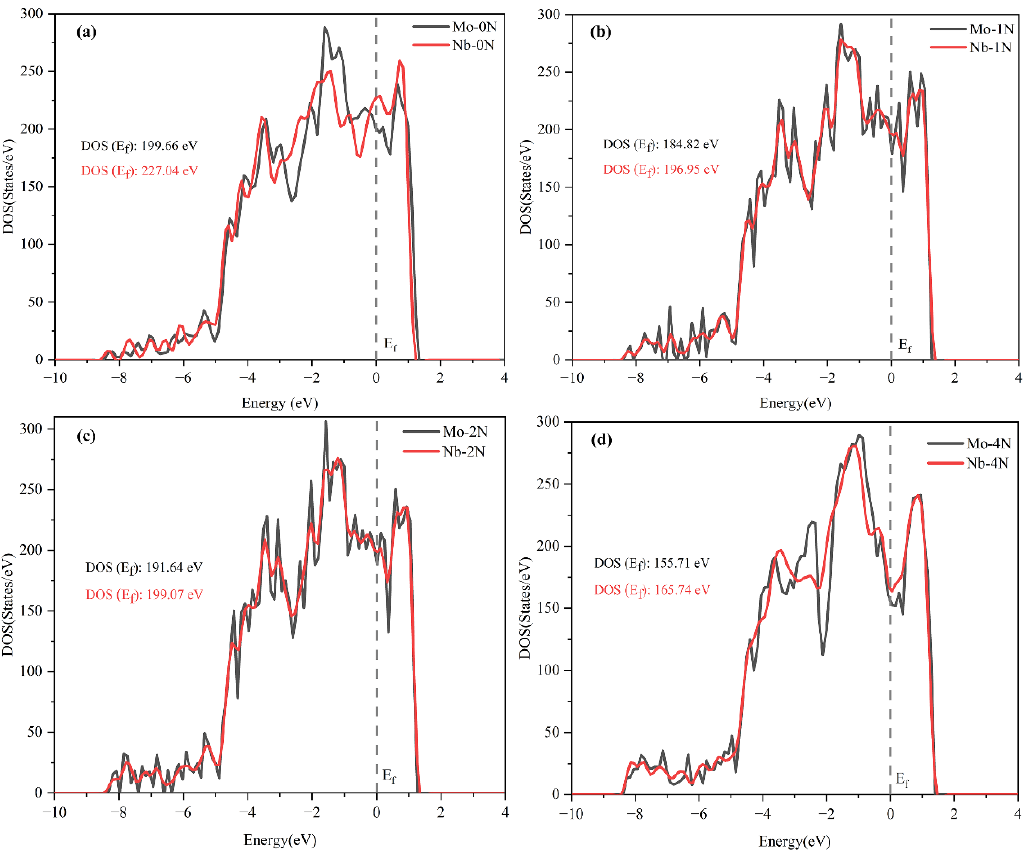
Figure 4. DOS of stainless steels with different nitriding degrees: ( a ) Fe105Cr22M; ( b ) Fe105Cr22MN1; ( c ) Fe105Cr22MN2; ( d ) Fe105Cr22MN4 (M = Mo or Nb).